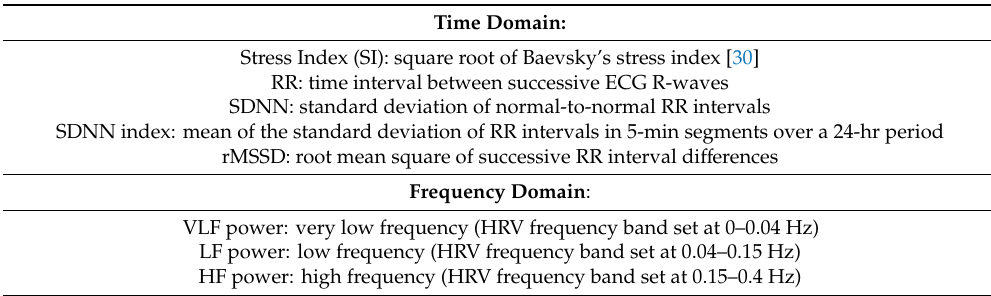
Table 2. Position (of human participant) and proximity (absence or presence of dog) combinations for the human–dog dyad proximity measures. Position Proximity Inactive * absence of dog Inactive presence of dog Lying absence of dog Lying presence of dog Sitting absence of dog Sitting presence of dog Standing absence of dog Standing presence of dog * Lying, sitting, and standing combined.